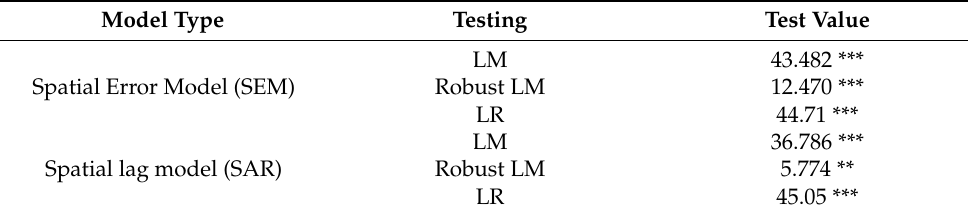
Table 5. LM, LR, and Hausman test